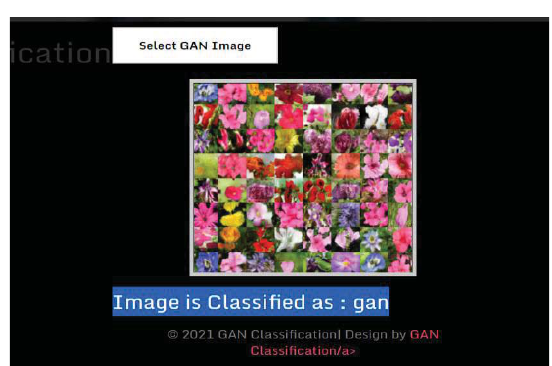
Fig. 12. The result on the web app (GAN generated image) Fig 11. depicts 8x8 GAN generated image i.e 64 images clustered together in 8x8 format. Fig 12. depicts result